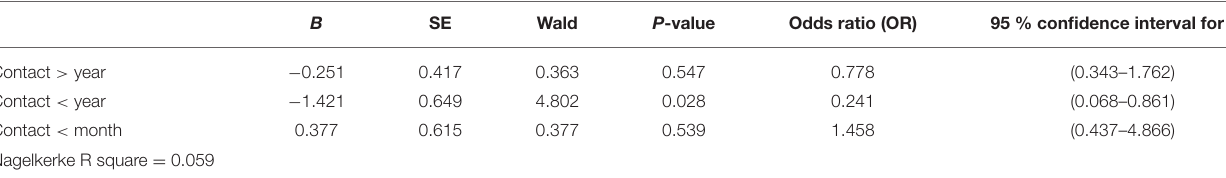
TABLE 2 | Binary logistic regression regarding timing of psychiatric outpatient and inpatient care in intimate partner femicide (IPF) and male-to-male homicide perpetrators. B